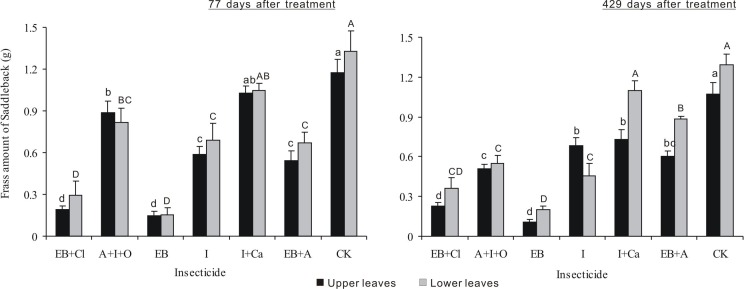
Frass amounts of L. Lepida larvae.Mean (± SE) frass amounts of L. Lepida larvae fed on upper and lower isolated leaves for 5 consecutive days after the application of six types of trunk injection at 77 and 429 days. N = 42 isolated branches in each observation time. 77 days after treatment, insecticides effect was significant (P < 0.001), and leaf position and insecticides × leaf position interaction effects were not significant. 429 days after treatment, insecticides and leaf position effects were significant (P < 0.001), and insecticides × leaf position interaction effect was not significant. Bars labeled with different lowercase or uppercase letters are significantly different at P = 0.05 from each other in the same leaf layer group (upper or lower leaves) based on Dunn’s range test.